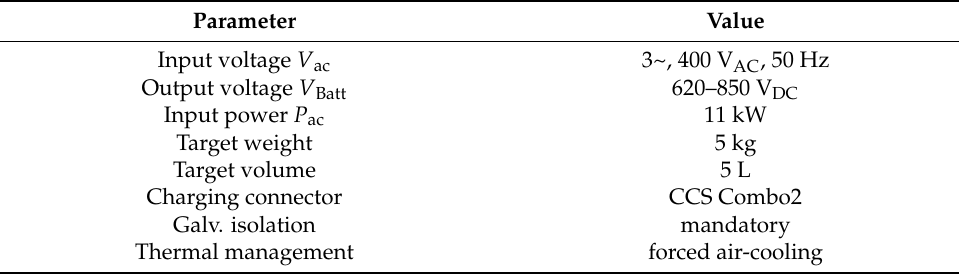
Table 1. Target specification of the portable off-board